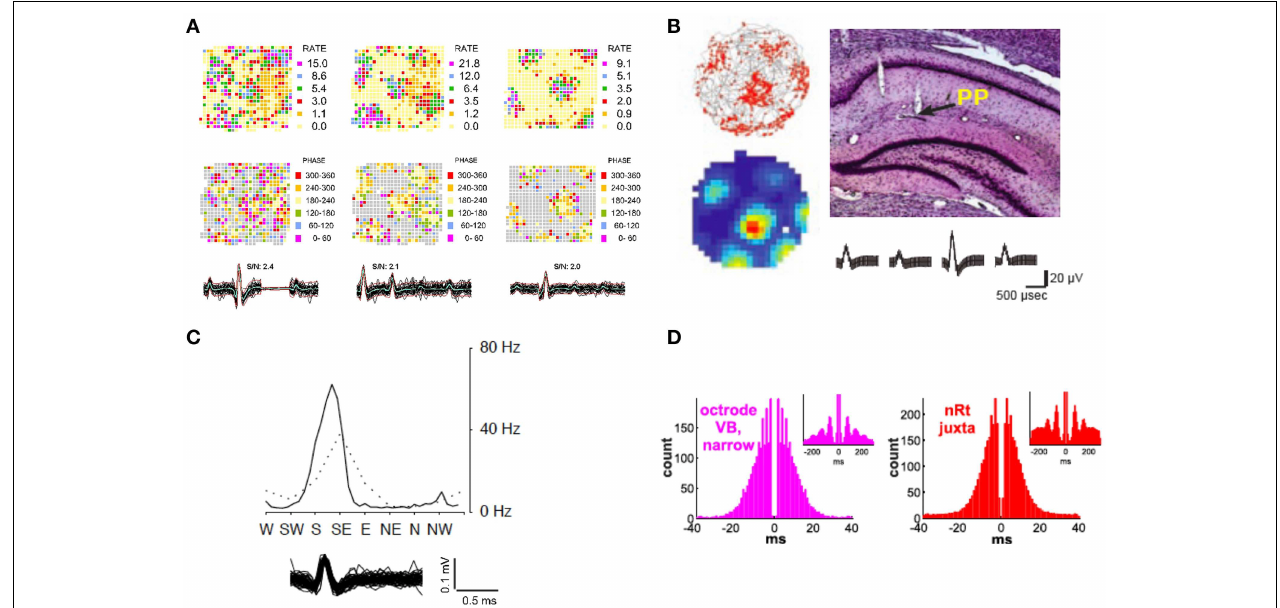
maximum rate, blue is minimum, i.e., 0Hz) (Top and Bottom Left respectively. Average waveform for putative axon (Bottom Right) (Adapted with permission from Leutgeb et al., 2007). (C) Head direction tuning exhibited by a putative axon in the hippocampus. The peak axonal activity occurs at apklpproximately 60Hz when the animal’s head is faced between S/SE (Adapted with permission from Leutgeb et al., 2000). (D) Autocorrelograms of an axon recorded in the ventrobasal thalamus using a silicon probe and a juxtacellularly recorded and labeled reticular neuron. The plots exhibit the longer bursts and spindle modulation (see insets) of reticular neurons that distinguish them from thalamocortical neurons in the ventrobasal thalamus (Adapted with permission from Bartho et al.,